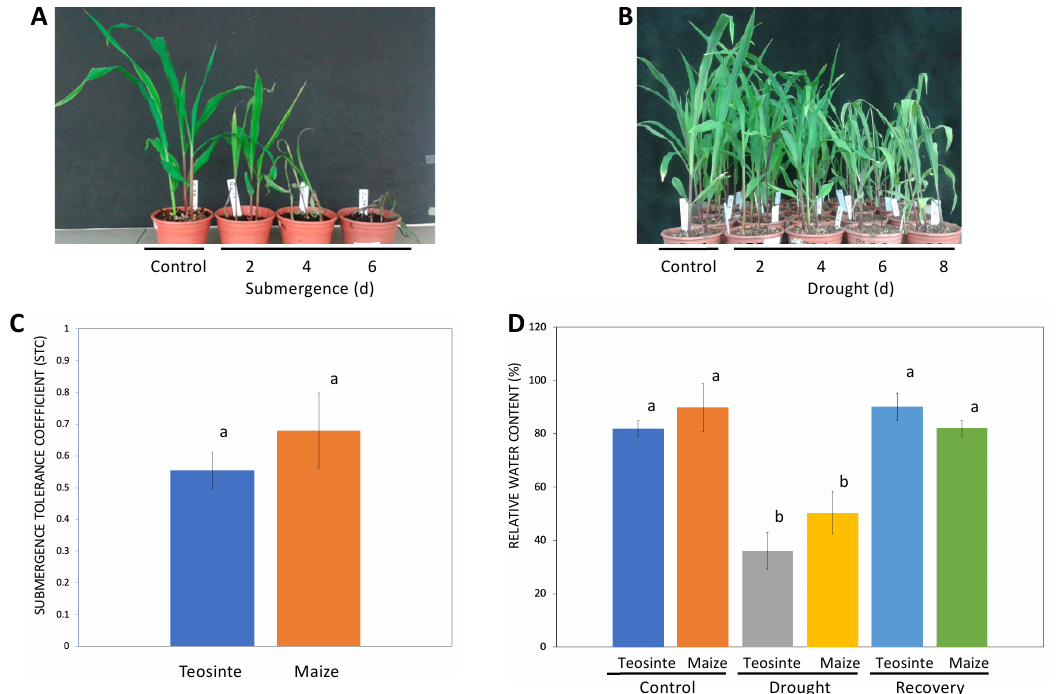
Figure 1. E ff ects of submergence and drought on maize and teosinte plants. ( A ) Plants exposed to submergence for 2, 4, and 6 days, and ( B ) plants exposed to drought for 2, 4, 6, and 8 days. Response of teosinte and maize plants to ( C ) submergence for 48 h, expressed as submergence tolerance coe ffi cient (STC), and ( D ) drought for 6 days and recovery 24 h after rehydration, expressed as relative water content (RWC) in the leaves. Data are means, with error bars representing ± SD of three biological replicates, each replicate consisting of six plants. Di ff erent letters above the error bars indicate statistically significant di ff erences between samples ( p < 0.05) in a Student’s t -test. Drought caused a reduction in the growth of maize plants when compared with control plants, but this reduction was stabilized, which may be explained by the fact that pots were maintained at a constant, intermediate water deficit condition, and not exposed to progressive drought